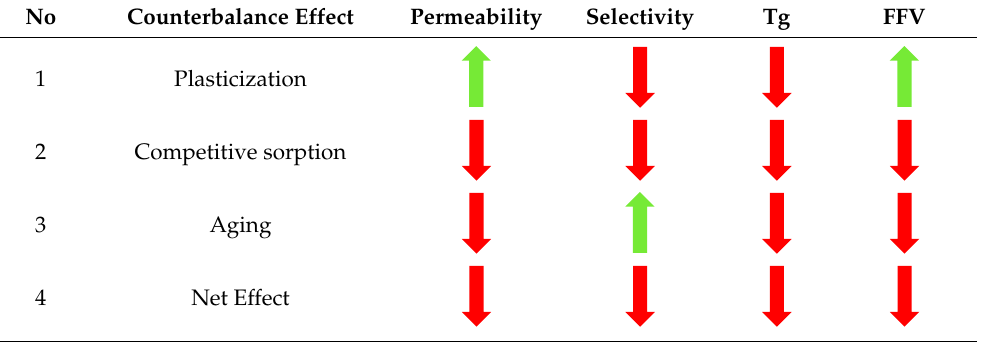
Table 3. Effects of plasticization, competitive sorption and aging, that counterbalance each other.